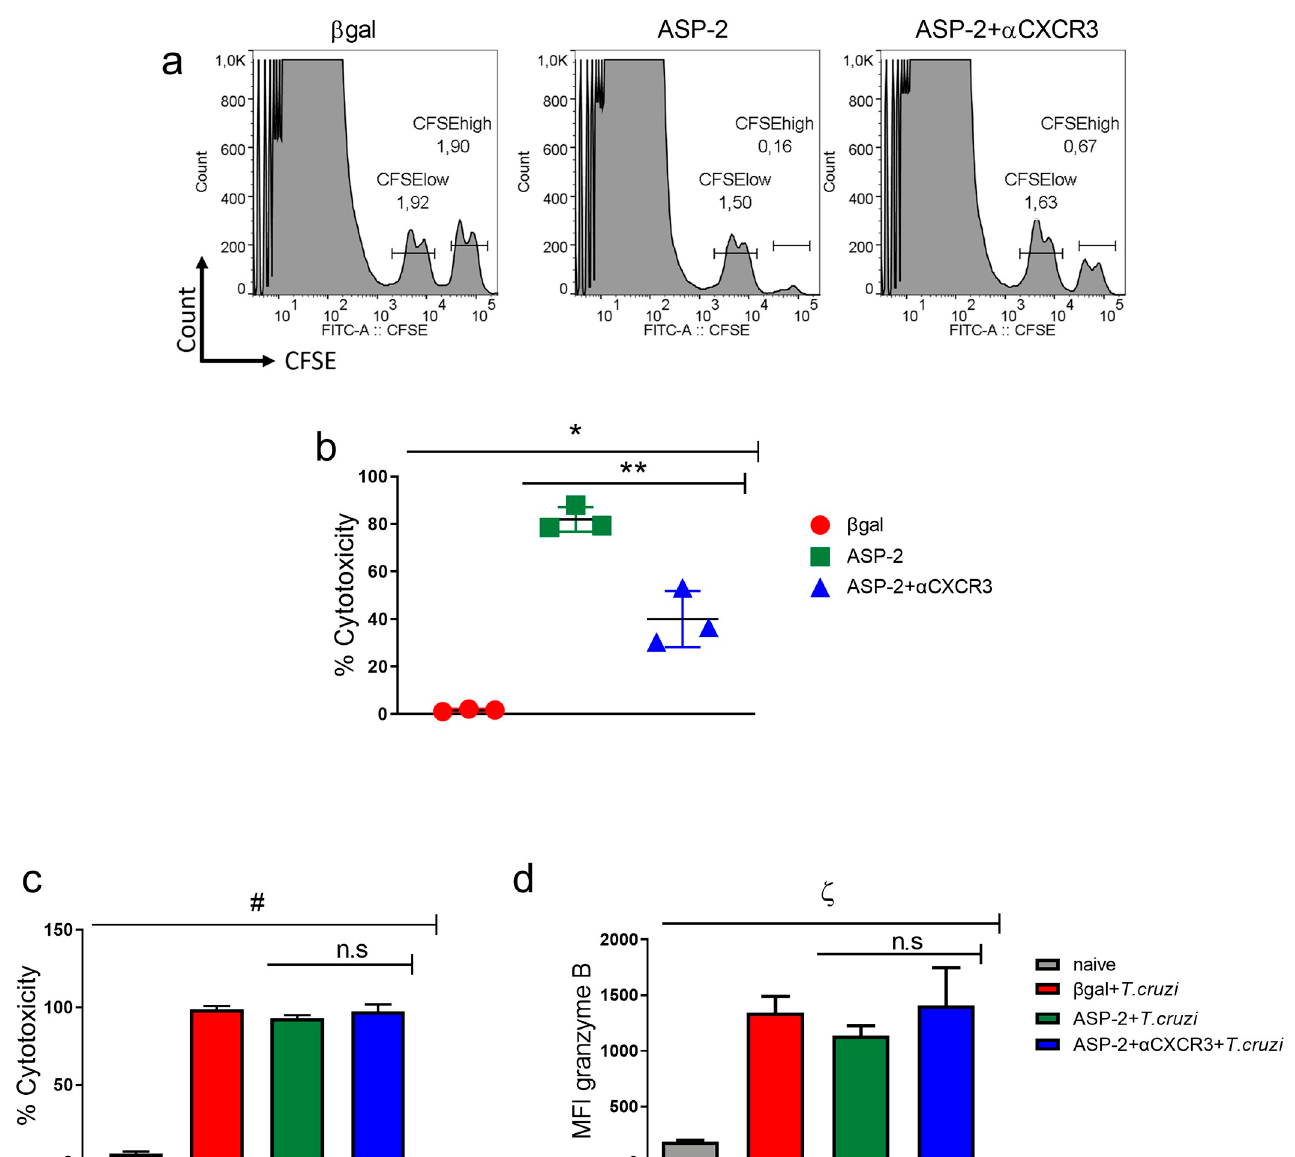
Fig 5. CXCR3 receptor is important to cytotoxicity of specific CD8 + T cells during the immunization. a-Histograms represent the frequency of CFSE low and CFSE high population that were transferred to β gal, ASP2, and ASP2+ α CXCR3 groups. After 12 hours of transference, the percentage of CFSE high cell lyses was calculated as described in the methods section. b-Cytotoxicity percentage of specific CD8 + T cells during immunization and treatment with anti-CXCR3. c- Percentage of cytotoxicity of specific CD8 + T cells during immunization, infection and treatment with anti-CXCR3 d-Granzyme B MFI on specific CD8 + T cells from β gal+ T . cruzi ,ASP2+ T . cruzi , and ASP2+ α CXCR3+ T . cruzi groups. Results are shown as individual values and as the mean ± SEM for each group (n = 3). One of three independent experiments is presented. Statistical analysis was performed using the One-Way ANOVA and Tukey’s HSD tests. Symbols indicate that the values observed were significantly different between the groups ( � p < .0001; �� p < .01; # p < .0001; z p = 0.0001) and n.s means no